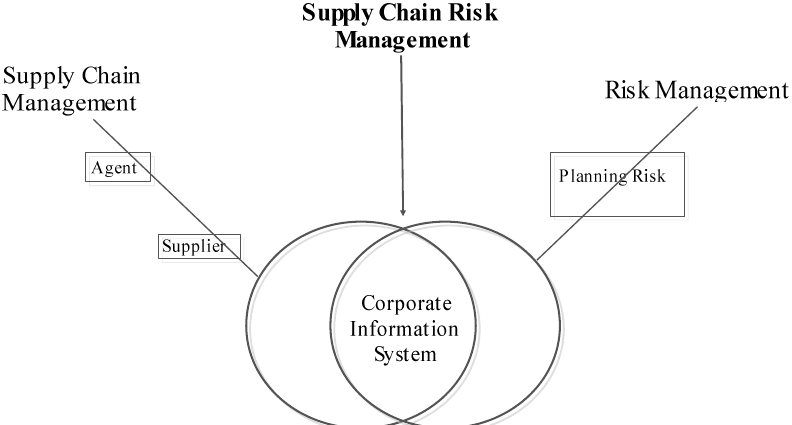
Fig 2. Research data model SCM and Risk management.